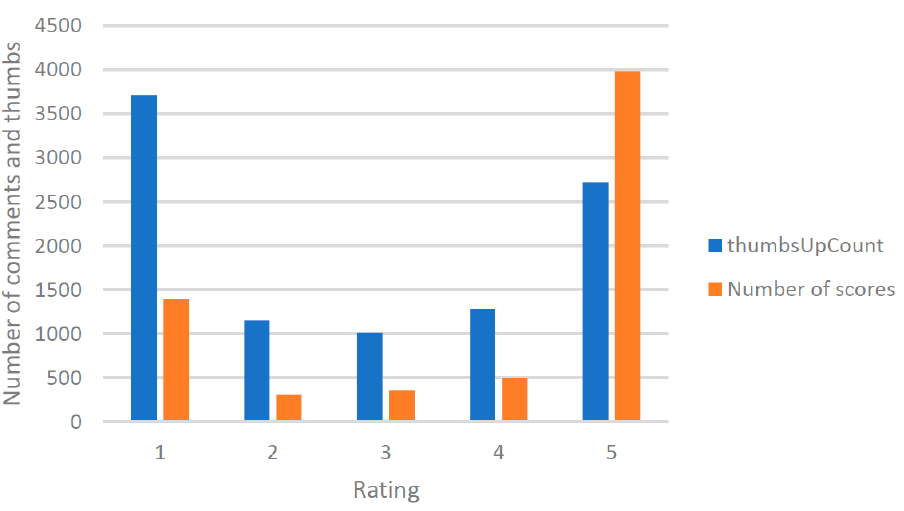
Figure 8. The usefulness of comments.